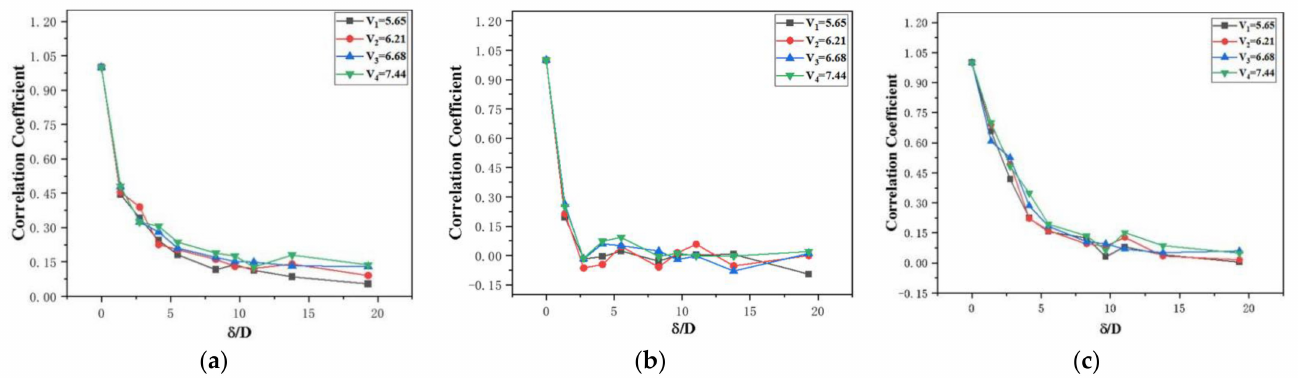
Figure 10. Spanwise correlation of wake wind velocity of the main beam in the static state. ( a ) Spanwise correlation of along-wind fluctuating wind velocity; ( b ) Spanwise correlation of across- wind fluctuating wind velocity; ( c ) Spanwise correlation of vertical-wind fluctuating wind velocity. It can be seen in Figure